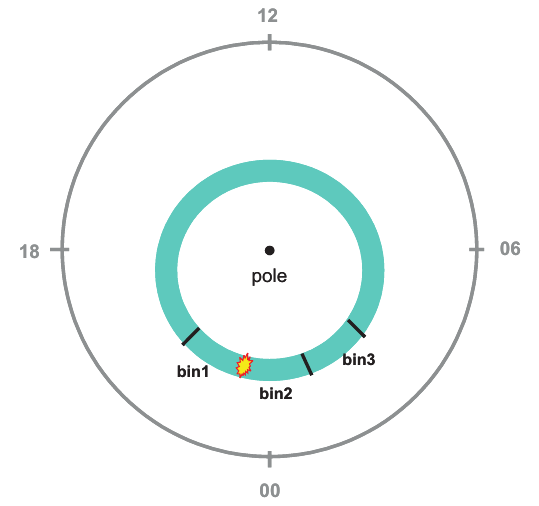
Fig. 2. Scheme of LT binning. Observations are sorted into three local time sectors wrt. the individual onset location. bin 1: 0–2h MLT before substorm onset; bin 2: 0–2h MLT past onset; bin 3: 2–4h MLT past